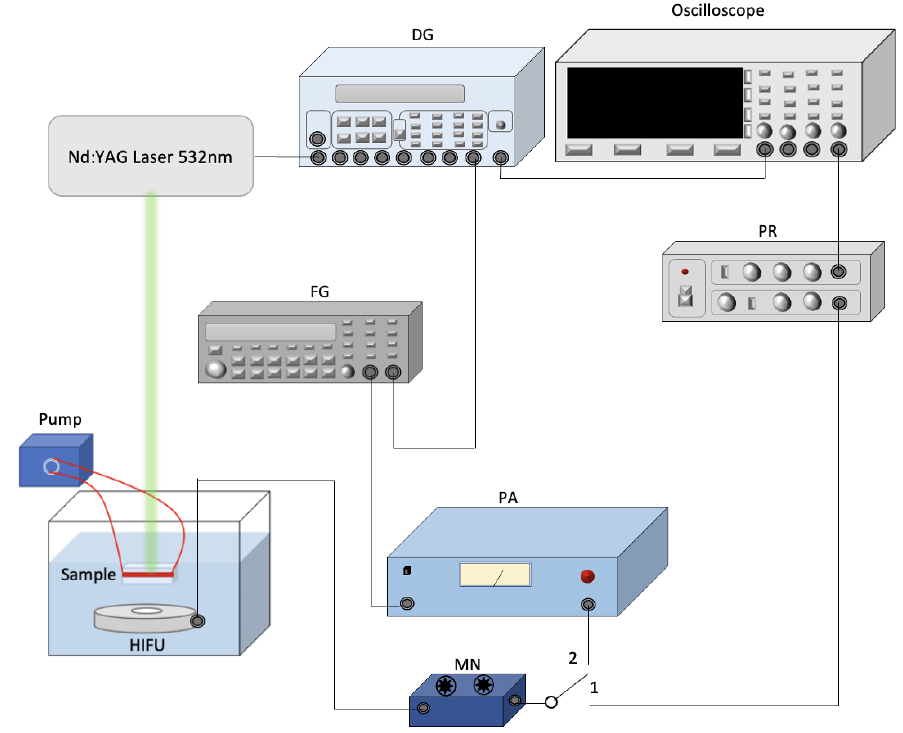
Figure 1. Schematic of the experimental setup for treatment in vitro. PA: power amplifier. DG: delay generator. PR: pulse-receiver. MN: matching network for HIFU transducer. FG: function generator. HIFU: high-intensity focused ultrasound. Position 1 is for detecting photoacoustic signals during the alignment process and Position 2 is for treatment.